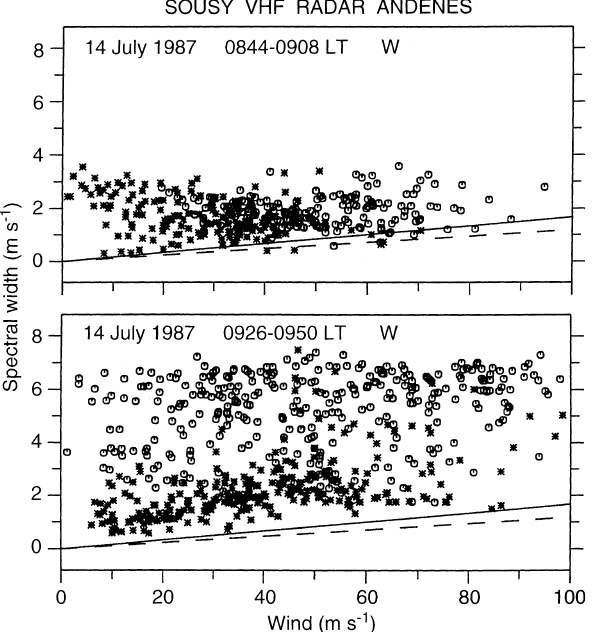
Fig. 3. Wind profile during a period of enhanced spectral width